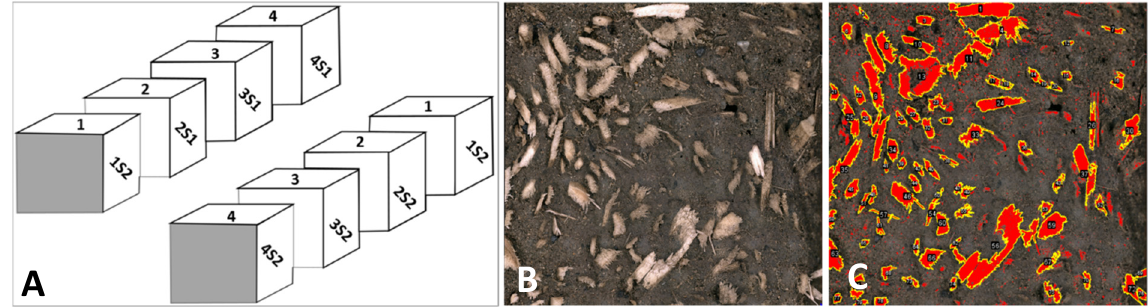
Figure 9. Bricks cross-sections ( A ), image scanning ( B ), and fiber counting ( C ). Each was further divided into 4 layers of dimensions 4*1 cm 2 with 16 squares of size 1 cm 2 , as shown in Figure 10.